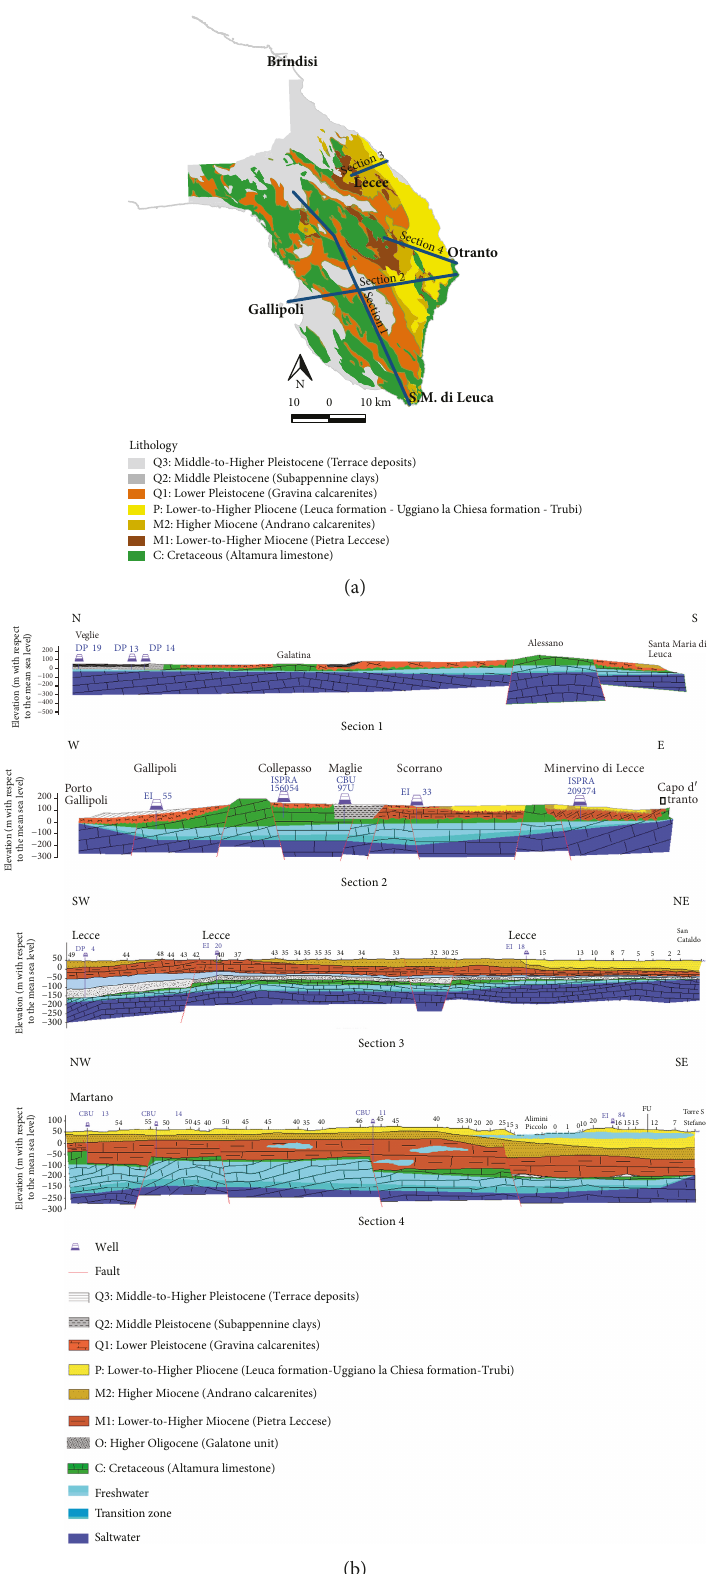
Figure 2: (a) Lithological map of the southern part of the Salento Peninsula. (b) Hydrostratigraphic cross sections along pro fi les drawn in sub fi gure (a). Fill colors and legend items are the same in both sub fi